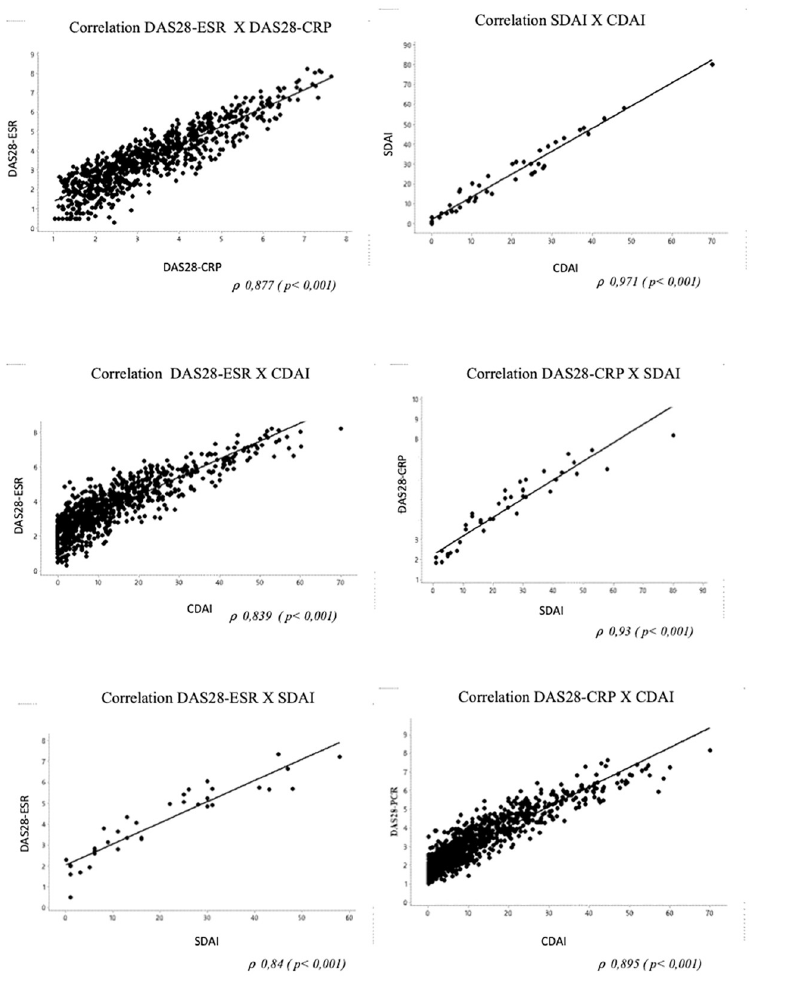
Fig 2. Correlation among the composite disease activity